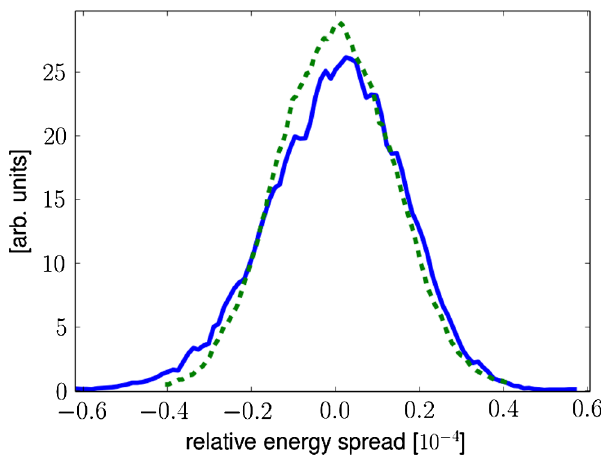
FIG. 3. Energy spread γ = γ 0 at the undulator exit, from initially delta-distributed beam. Direct Monte Carlo (solid) and stochastic integration [dashed, diffusion coefficient corresponding to Eq. (3)], for 17.5 GeV electron beam, K ¼ 1 . 0 , over 100